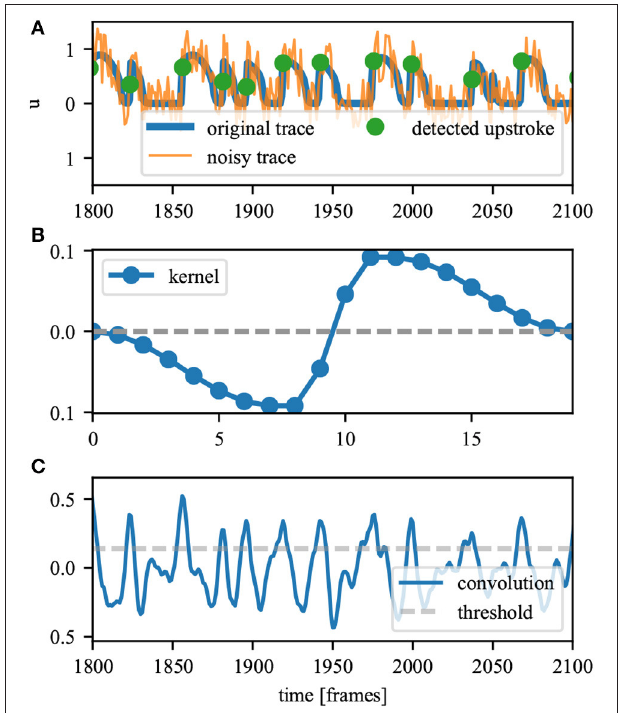
FIGURE 2 | Sketch of the method used for defining the upstrokes. (A) The original and noisy time trace. The dots show the final times of the upstroke based on the noisy time trace. (B) The kernel which is correlated with the noisy signal in (A) to find the upstroke position. (C) Result of the correlation of the noisy signal in (A) and the kernel in (B) . Local maxima identify the upstroke position (as indicated in A ). A threshold is used to ignore unclear